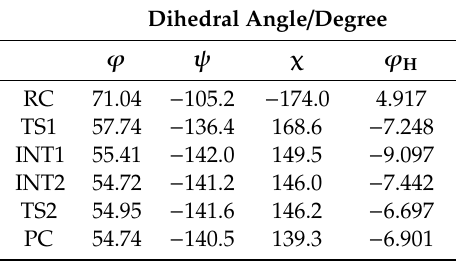
Table 4. Dihedral angles (degrees) of the optimized geometries for the syn conformation in the phosphate-catalyzed reaction.